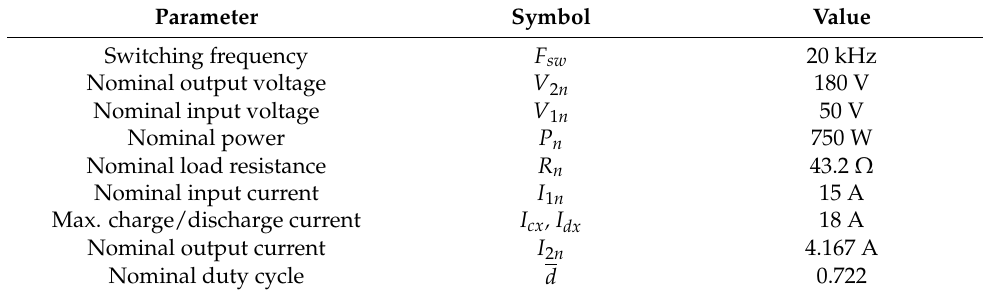
Table 3. Rated values of the system.